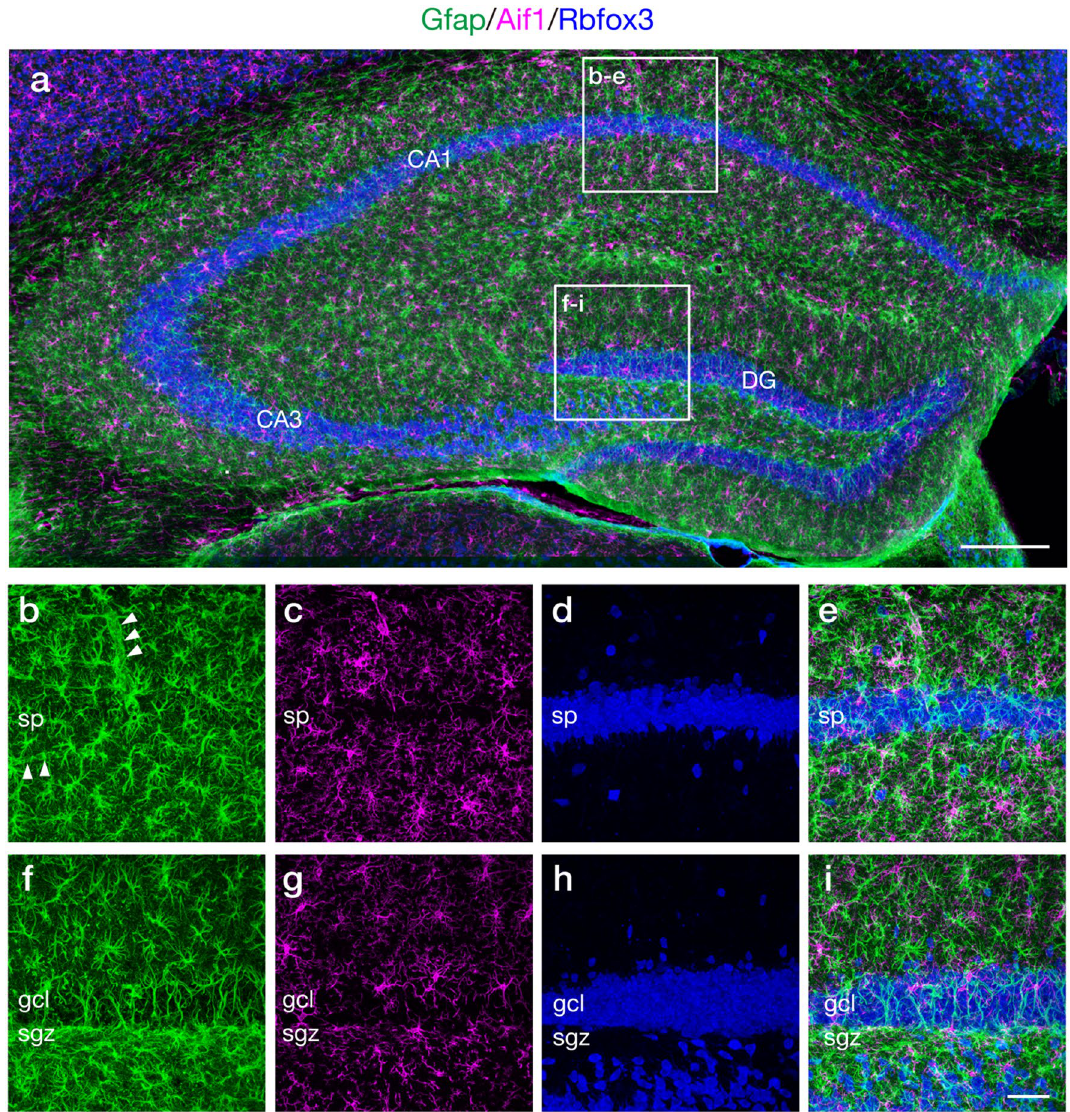
Figure 5. Fluorescence triple labeling with multiplex FT-GO IF. (a) Gfap (green), Aif1 (magenta) and Rbfox3 (blue) multiplex FT-GO IF in the mouse hippocampus (n = 3 animals). ( b–i) Higher magnification images in rectangles in ( a ). ( b–d , f–h) Representative images of triple labeling for Gfap ( b,f ), Aif1 ( c,g ) and Rbfox3 ( d,h ). ( e,i) Triple merged images of ( b–d,f–h ). CF488A, CF568 and CF647 tyramide are used for color development of Gfap, Aif1 and Rbfox3 IRs, respectively. Arrowheads indicate tubular IR for Gfap. CA1 cornu ammonis 1, CA3 cornu ammonis 3, DG dentate gyrus, gcl granule cell layer, sg z subgranular zone, sp stratum pyramidale. Scale bars: 200 µm in ( a ) and 50 µm in ( i